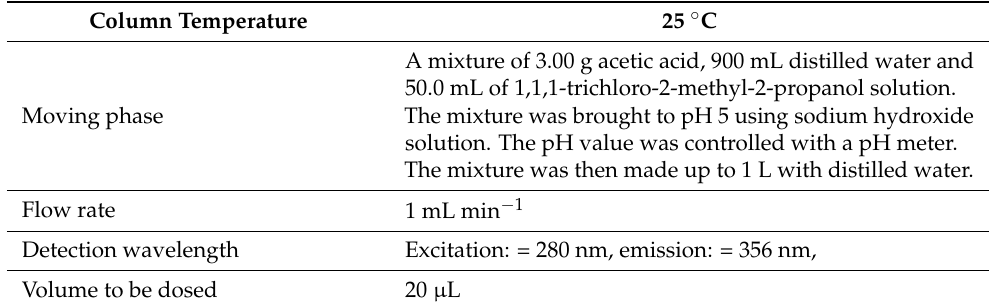
Table 6. Chromatographic analysis parameters for the determination of tryptophan. Column